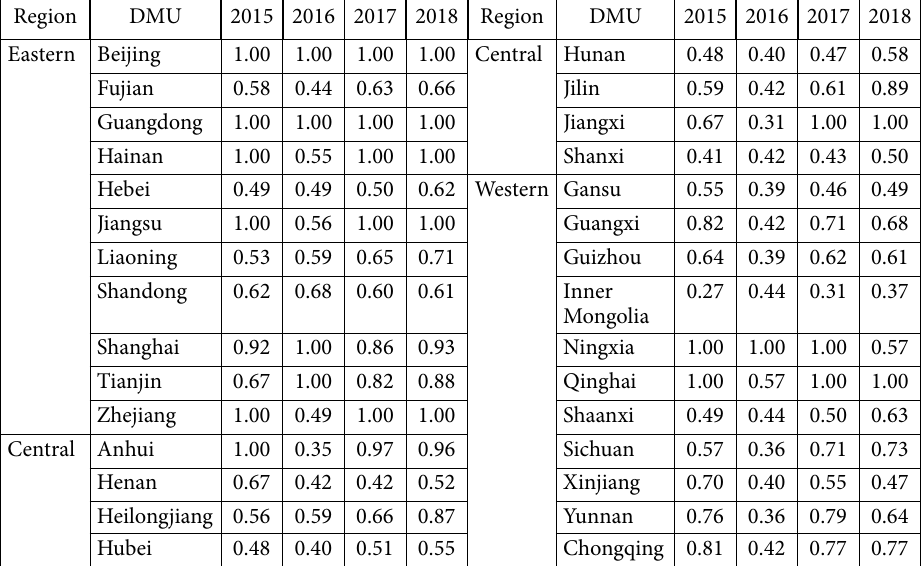
Table 6. Knowledge innovation efficiency from 2015 to 2018 Region